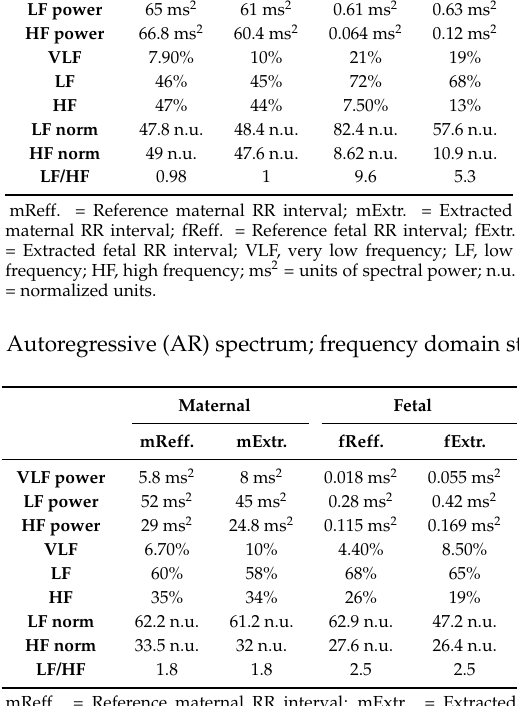
Table 7. Fast Fourier Transform (FFT) spectrum; frequency domain statistics. Maternal Fetal mReff.